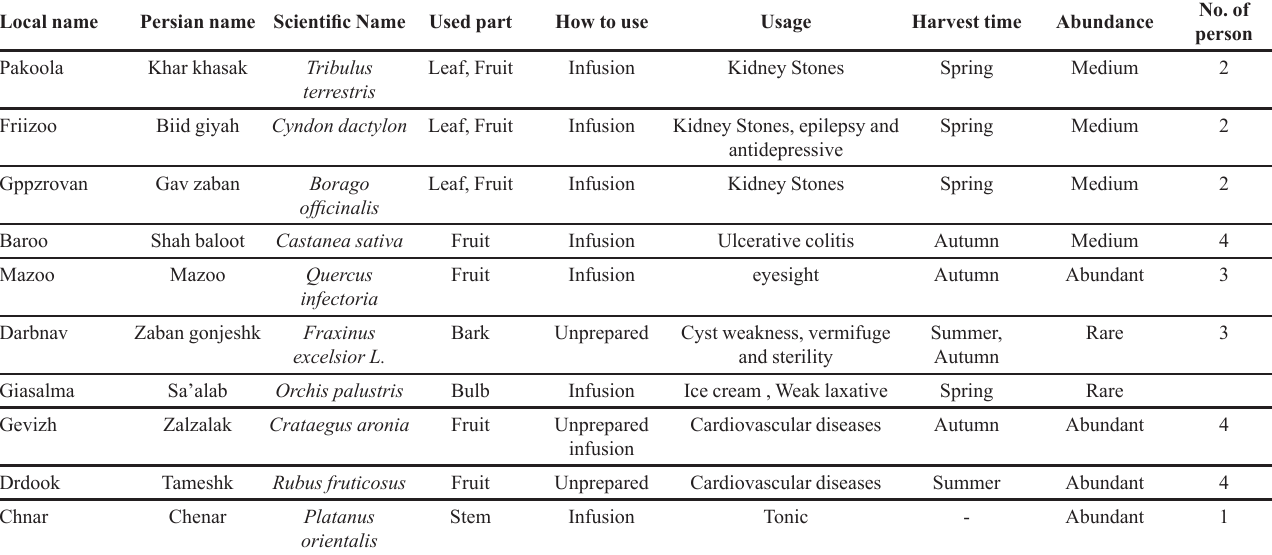
TABLE II - Ethnomedicinal data collection